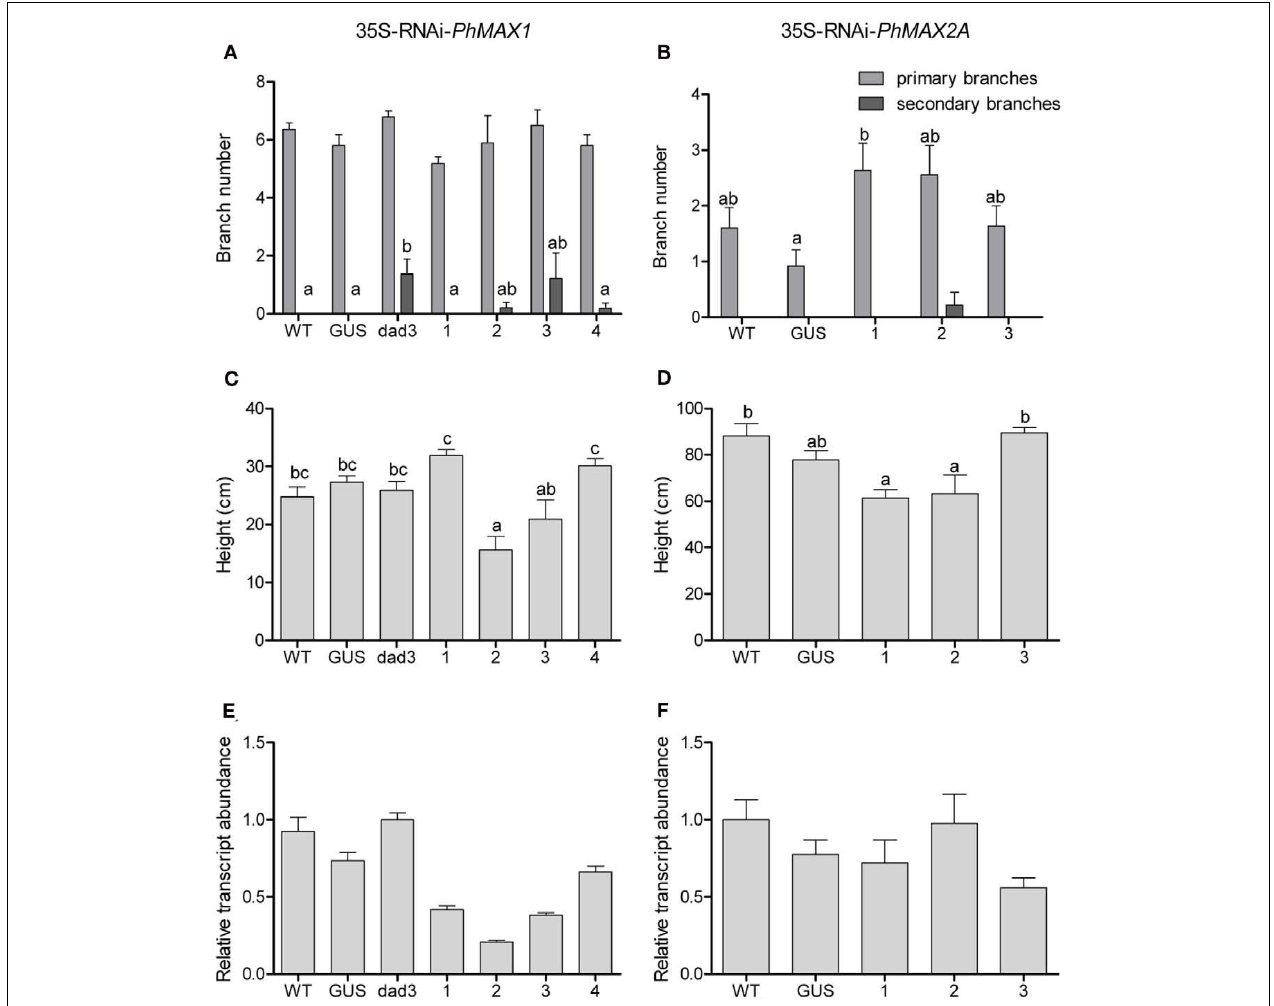
FIGUREA1 | Branching phenotype and target gene transcript levels in petunia PhMAX1 or PhMAX2A RNAi lines. After selection